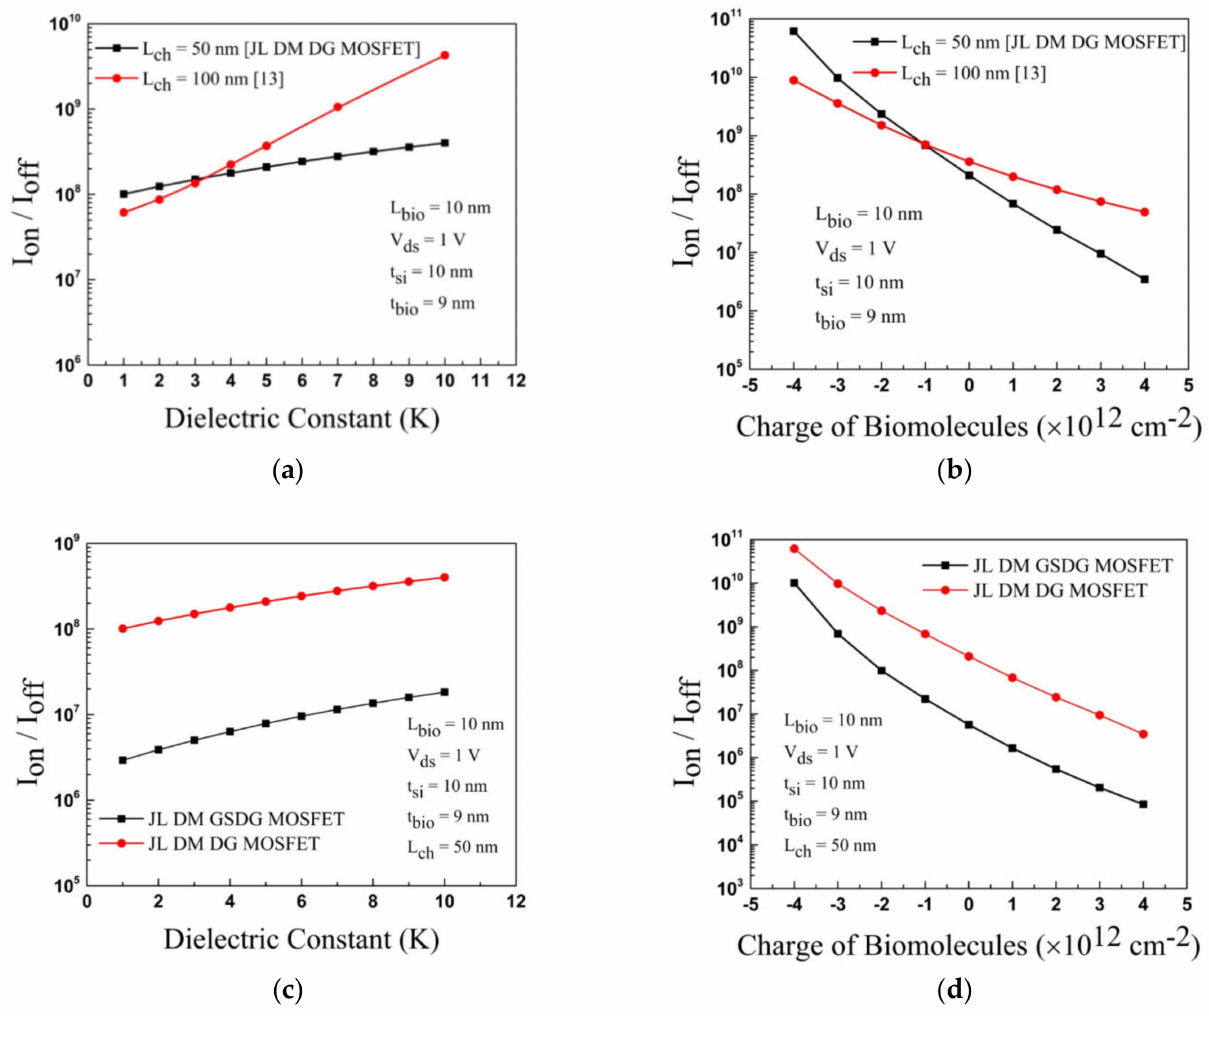
Figure 13. Plot of the I on /I off ratio for JL-DM-GSDG-MOSFET and [13]: ( a ) neutral biomolecules; ( b ) charged biomolecules. Plot of the I on /I off ratio for the JL-DM-GSDG-MOSFET and JL-DM-GSDG- MOSFET: ( c ) neutral biomolecules; ( d ) for charged